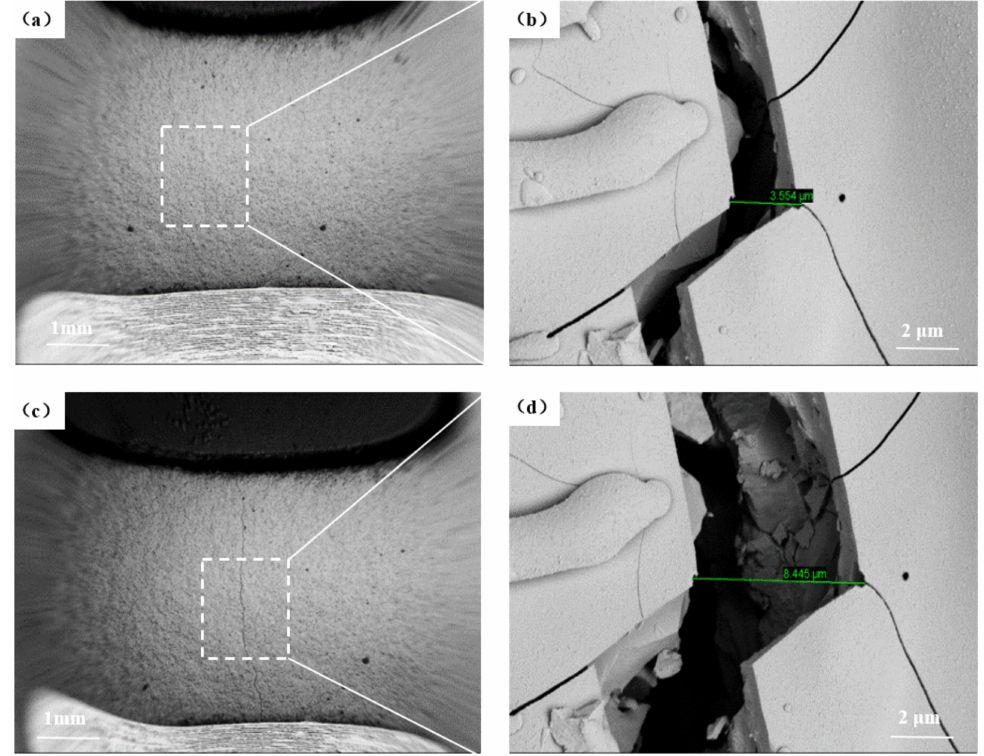
Figure 8. In situ SEM surface crack propagation when the specimen was held at 766 ◦ C and subjected to a variable loading profile: ( a , b ) 250 N; ( c , d ) 300